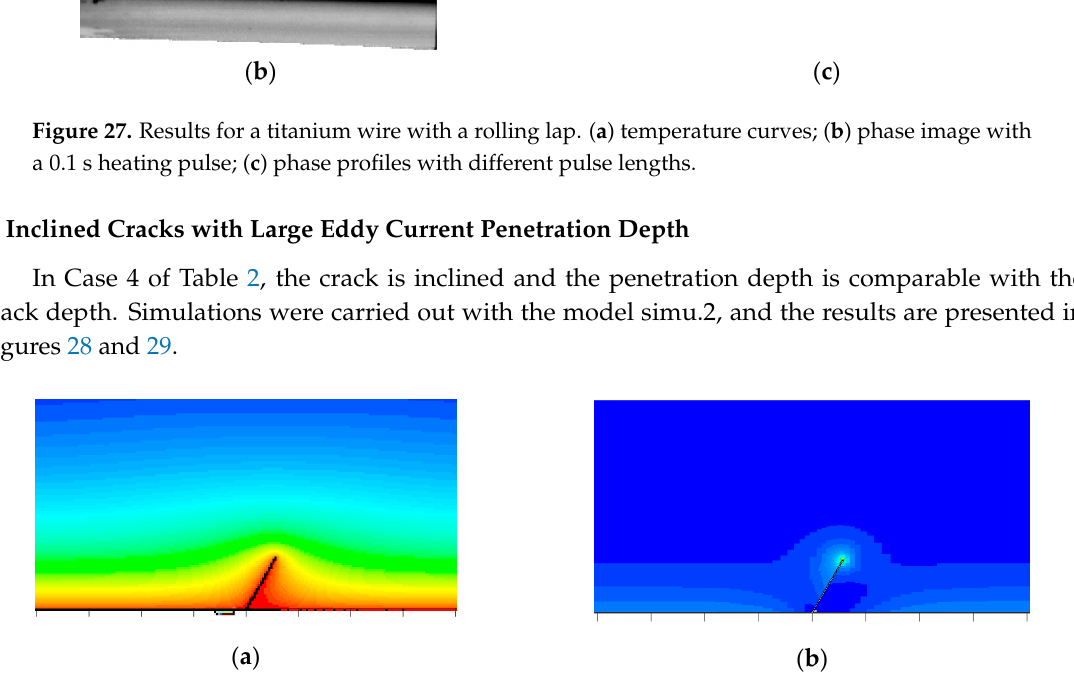
Figure 28. Simulation model (simu.2) results shown in close-up to an inclined surface crack θ = 30° and with a depth of 1 mm. Material: non-magnetic steel, the properties are listed in Table 1.